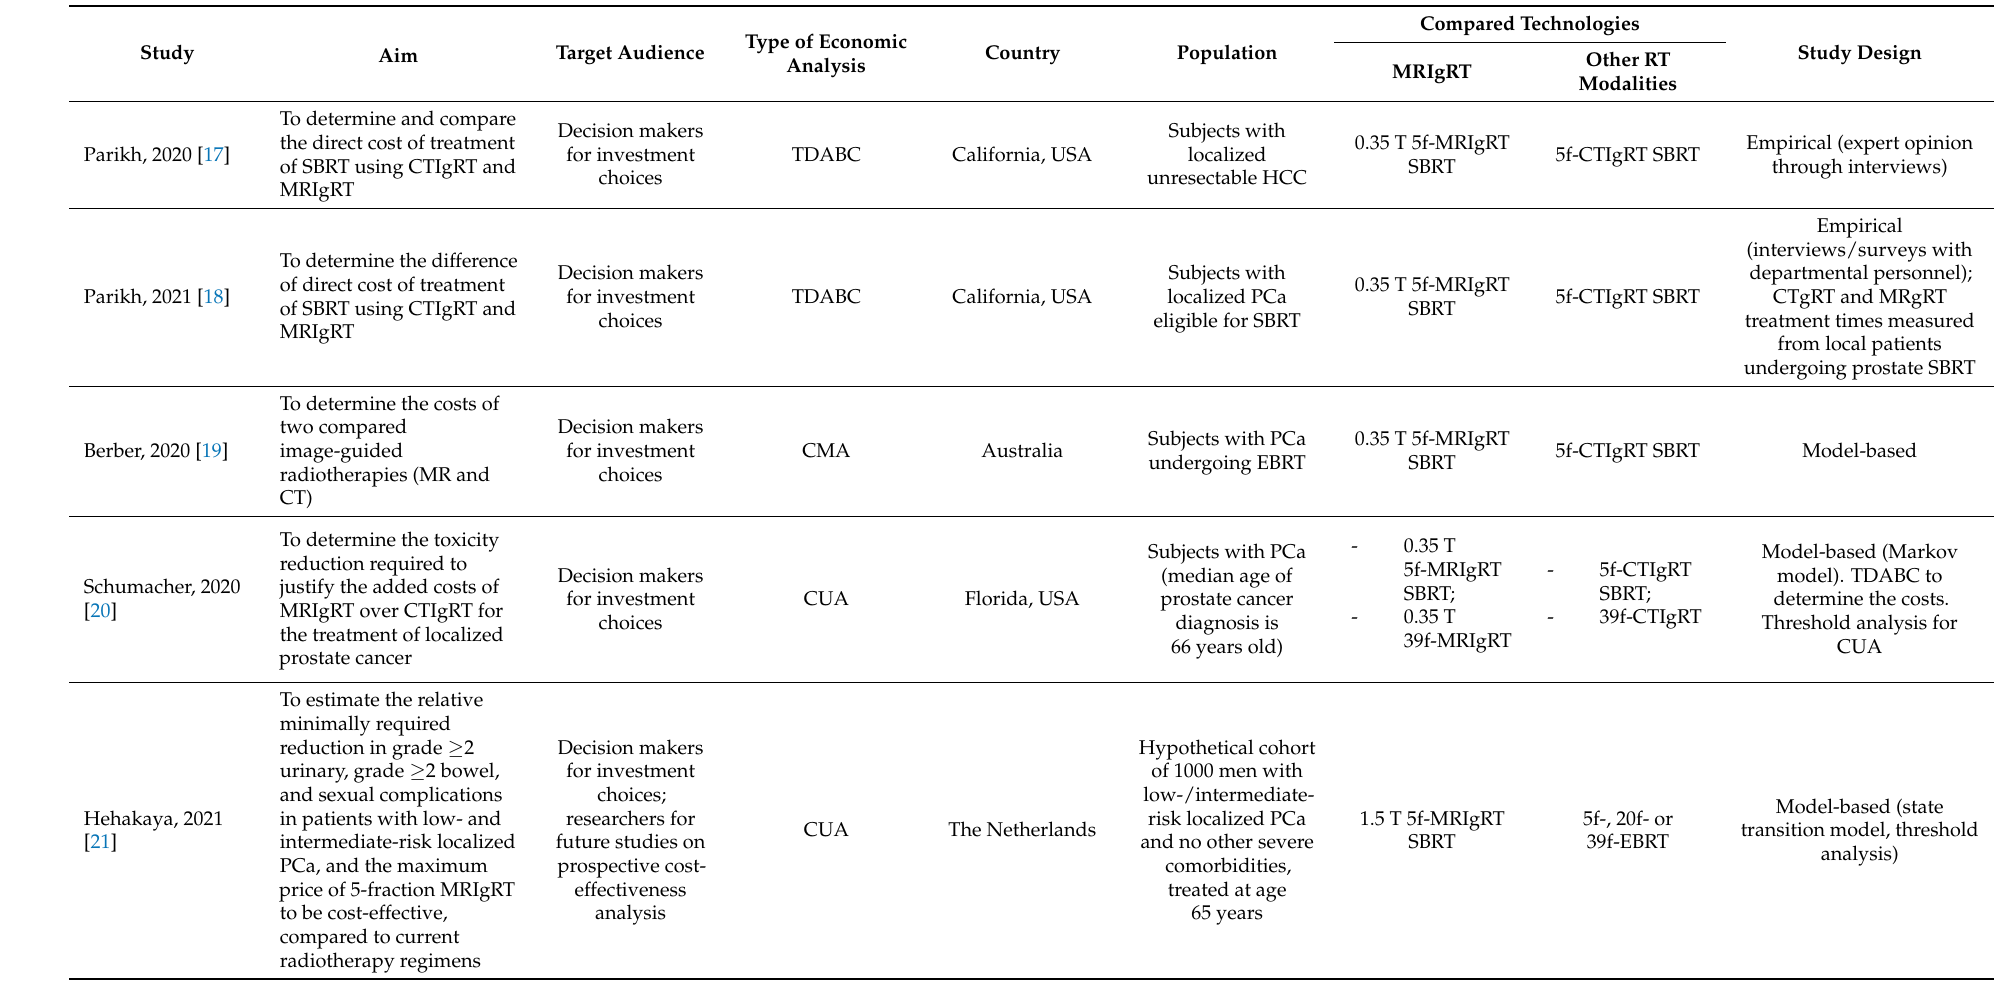
Table 1. Characteristics of the included